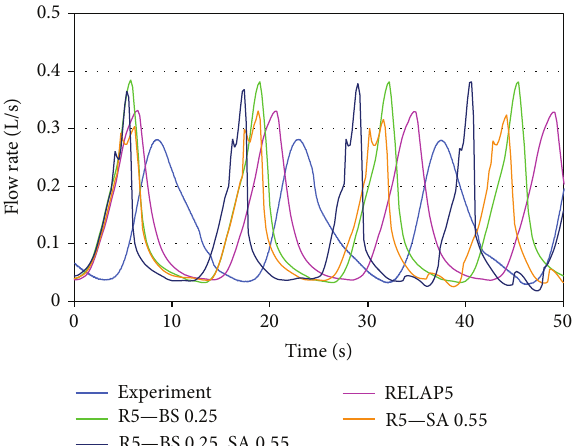
Figure 17: Void fraction at the riser: experimental and RELAP5 data obtained with different flow regime transition